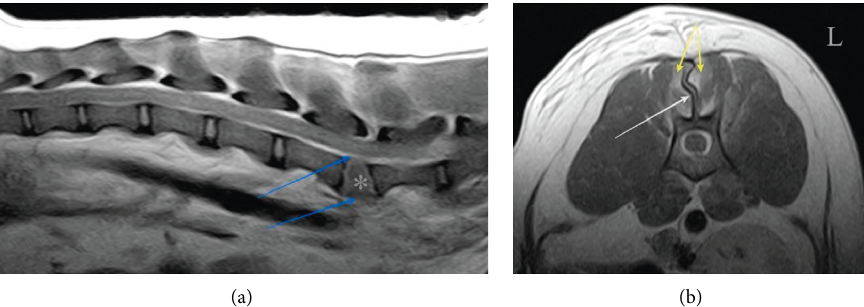
Figure 6: Postcontrast sagittal (a) and transverse (b) T1-weighted MR images of two different dogs showing rupture of dorsal and ventral annulus fibrosus of L3-L4 intervertebral disc (blue arrows), increase in the size of L3-L4 intervertebral disc space ( ∗ ), fracture of spinous process of L3 (white arrow), and enhancement of epaxial muscles (yellow